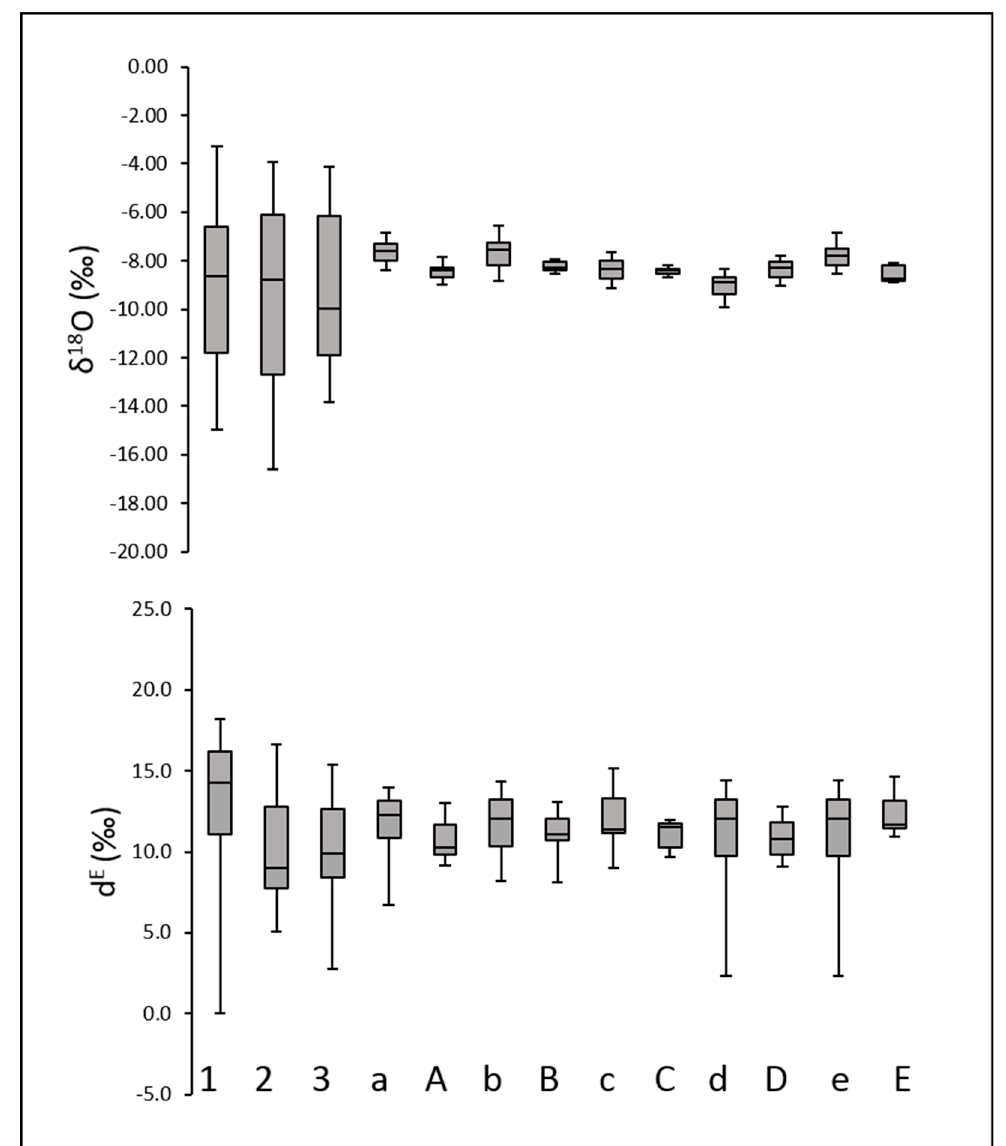
Figure 3. Box-plots for δ 18 O (above) and d E (below) of all water samples. Letters from a to e and numbers from 1 to 3 recall surface water and precipitation, respectively. Capital letters from A to E refer to groundwater from the apical parts of alluvial fans (in form of aggregated isotopic values from wells). The whiskers represents the 10th and 90th percentiles, the box limits indicate 1st and 3rd quartiles (1Q and 3Q) and the line within the box mark is the median. For further details, readers are referred to Tables 3 (precipitation) and 4 (surface water and groundwater).